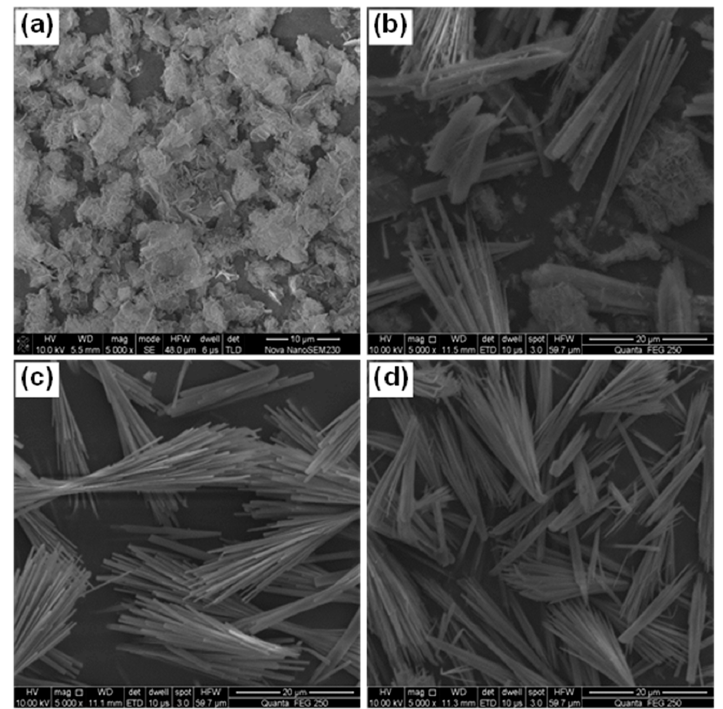
Figure 7. Scanning electron microscopy (SEM) images of whiskers obtained at different MgSO 4 concentrations ( a ) 1.5 mol/L; ( b ) 2.25 mol/L; ( c ) 2.5 mol/L; ( d ) 3.0 mol/L.